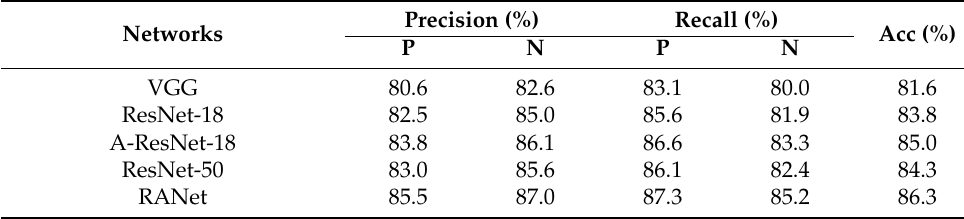
Table 3. Comparison of different audio-classification